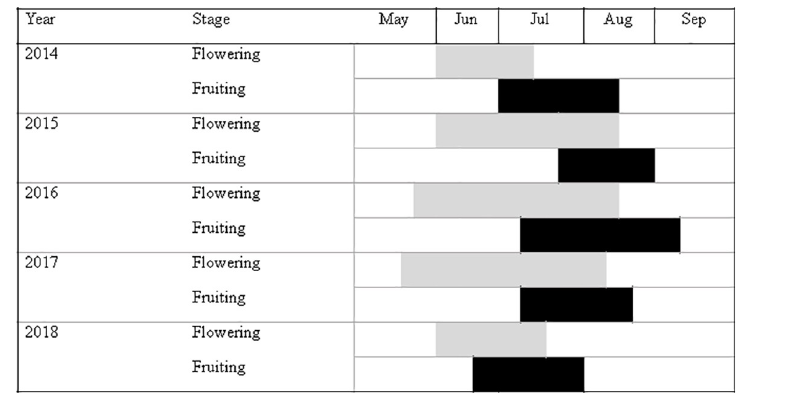
Fig 2. Flowering and fruiting period of Asperula naufraga during five consecutive years (2014–2018).